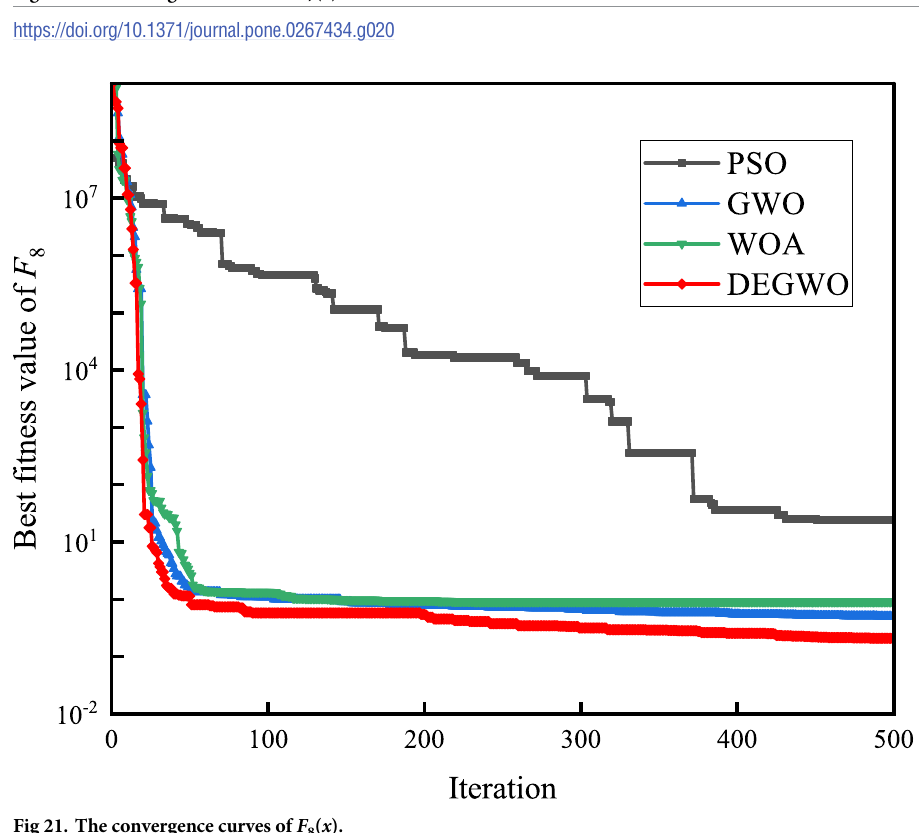
Fig 21. The convergence curves of F 8 ( x ).